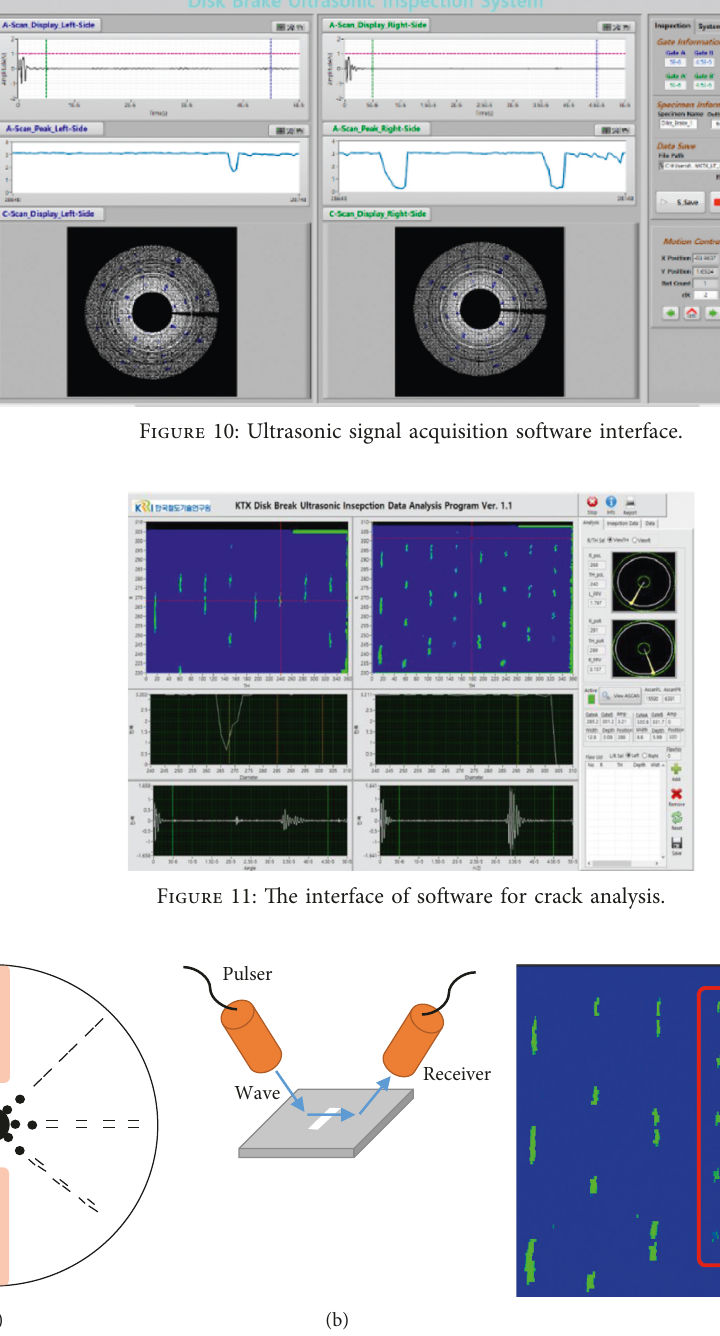
Figure 12: Experiment setup of standard-type crack: (a) crack location, (b) experimental setup, and (c) C-scan